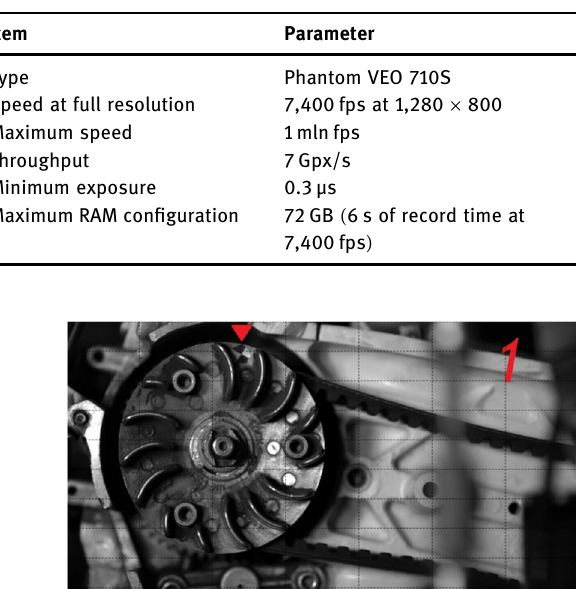
Table 1: Selected features of high - speed camera Phantom VEO 710S